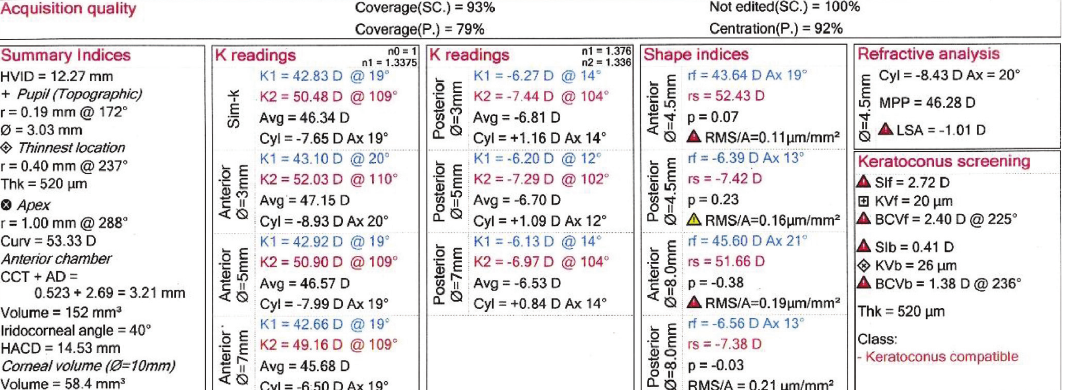
Figure 2: Pre-CXL (Sirius v 2.6, CSO, Italy) quad map of an 8-year male with keratoconus.